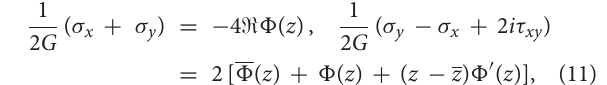
Z a − Figure 2 shows the distribution of normalized normal (2 Ga / P ) and tangential q ( x ) (2 Ga / P ) q ( x ) contact tractions ¯ = in the case µ 0 0.25 for different values of ratio Q / P . The = distribution of contact pressure p ( x ) is permanent, and the ¯ distribution of tangential tractions q ( x ) has characteristic breaks ¯ at points x c of transition from the adhesion zone to slip = ± zones. For values Q / P 0.05, 0.1, 0.15, and 0.2, the relative = size c / a of the adhesion zone is 0.894, 0.775, 0.633, and 0.447, respectively. In the case of Q / P 0, tangential tractions do not = appear ( q ( x ) 0) in the contact area (corresponding to a smooth ≡ µ 0 , we have a sliding contact). In the case of Q / P =